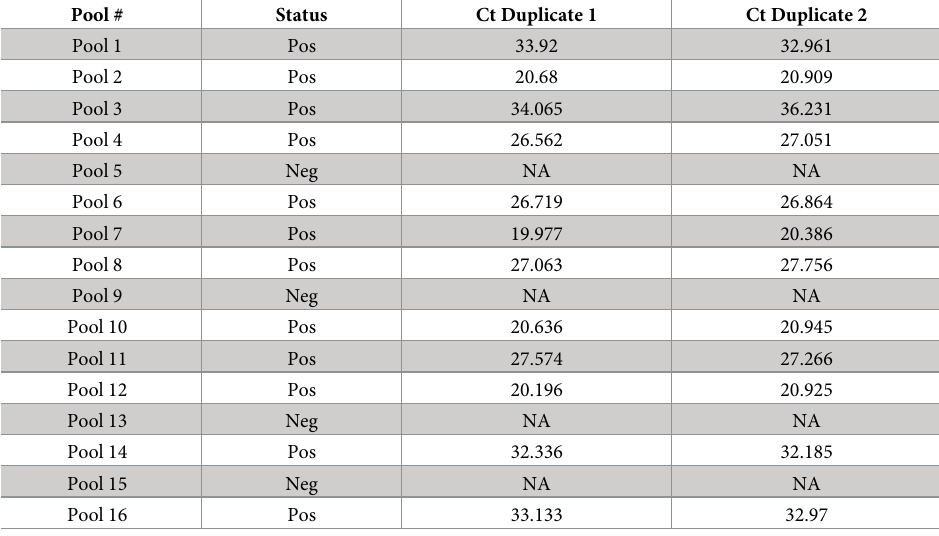
Table 3. Human COVID-19 sample pooled testing qRT-PCR